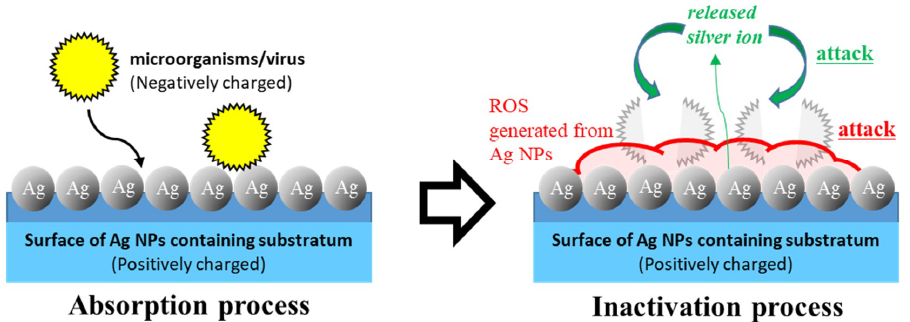
Figure 3. The mechanism for microbicidal and antivirus activities of the Ag NP chitin nanofiber sheet (CNFS). To prevent contact infection of healthcare workers (HCWs), an Ag NP chitin nanofiber sheet (CNFS) was developed, showing strong microbicidal activity against microorganisms / viruses via reactive oxygen species (ROS) and silver ions on the surface of substratum.